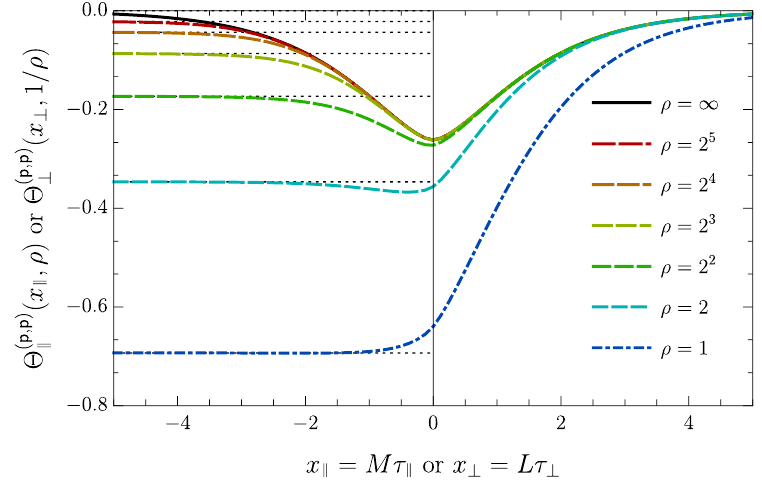
( p , p ) ( x ρ ) for different values for the aspect ratio ρ . δ , δ